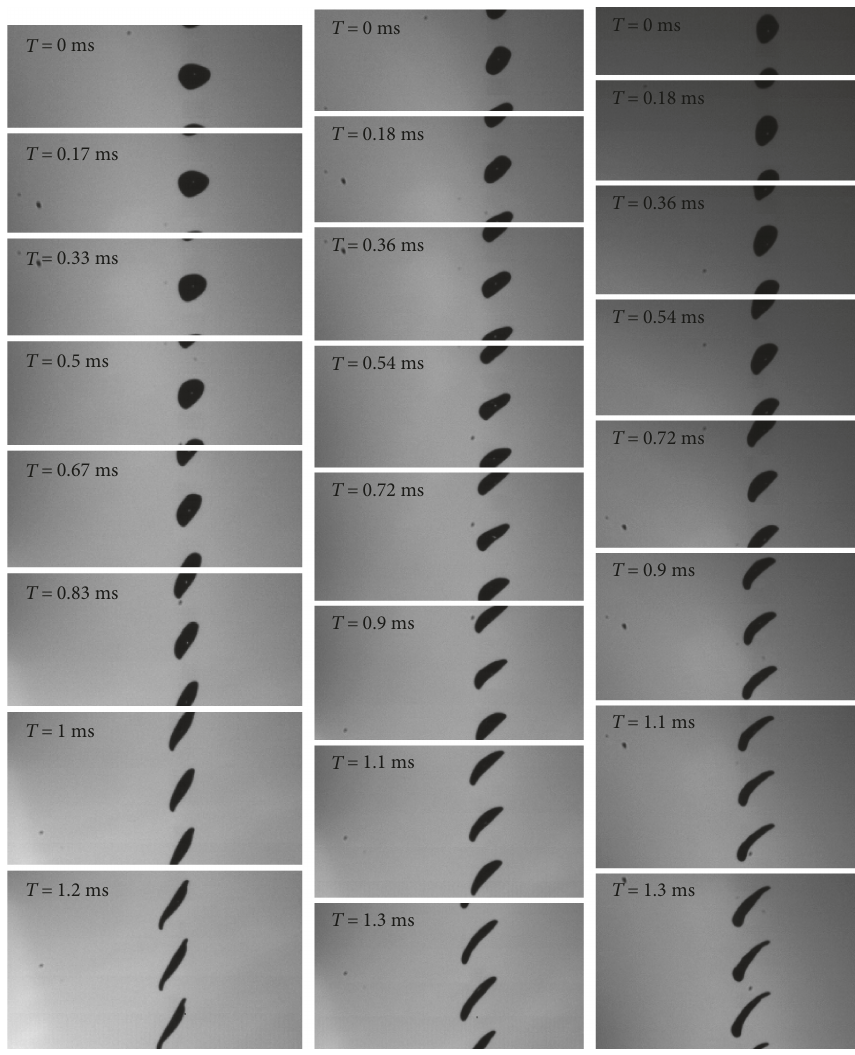
Figure 13: Recorded droplet evolution for cases #4 (left), #5 (centre), and #6